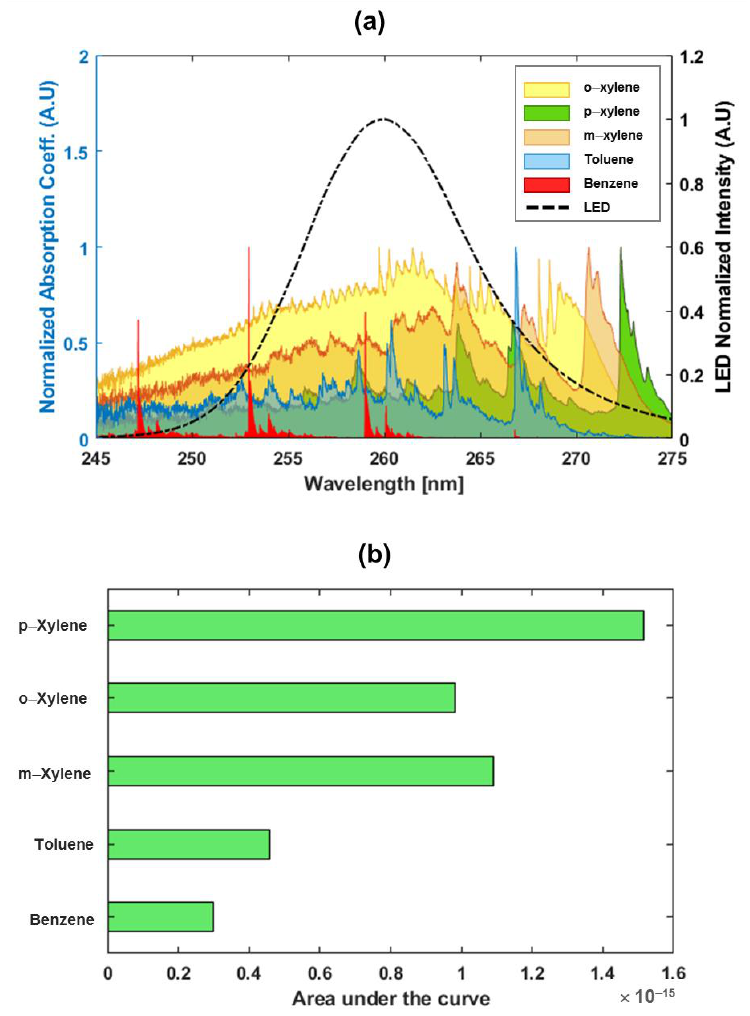
Figure 4. ( a ) LEDs emission spectrum mapped on the absorption spectrum of benzene, toluene and m-xylene, p-xylene and o-xylene. Data was sourced from HITRAN [18] and then plotted ac- cording to the scale. Each spectrum is normalized by its maximum peak value. ( b ) The area inte- gral of BTEX components for a wavelength range 245–275